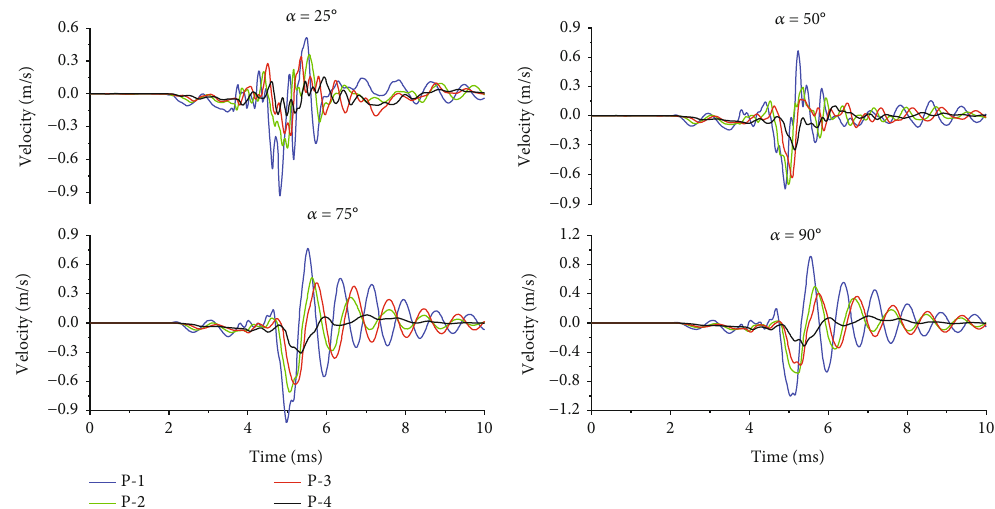
Figure 13: Vibration velocity of monitoring particles under the action of the blasting stress wave at various joint angles.